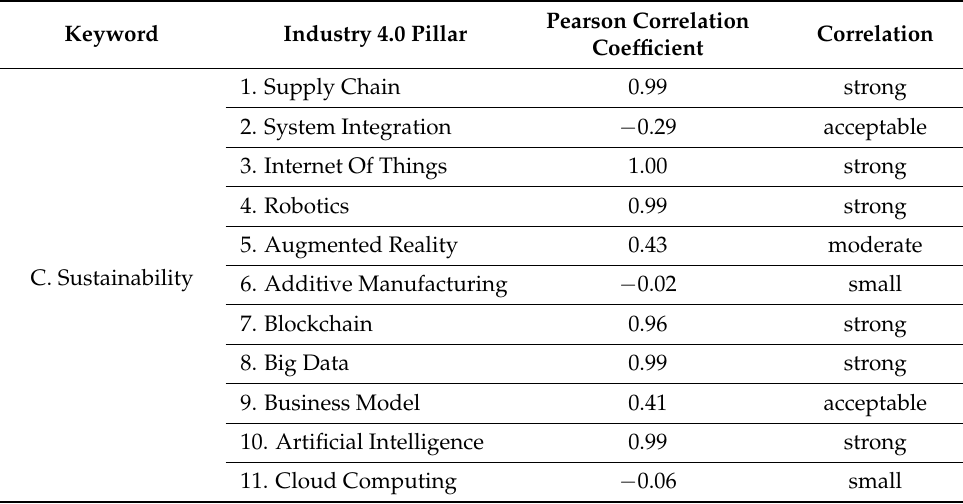
Table 6. Correlation matrix for “Sustainability” and the Industry 4.0